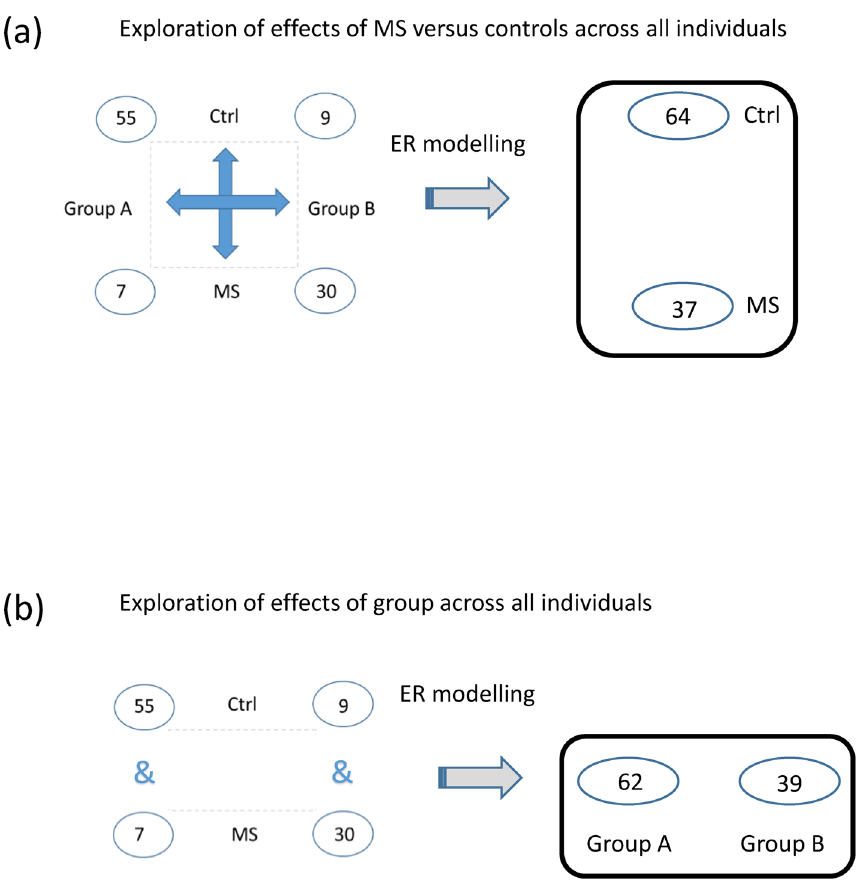
Figure 3. Cohort 1. Schematic description of ER modelling. The data are considered as two-pseudofactors, each on two levels, and the impact of one factor is omitted during exploration of the other. ER modelling allows data on all controls and all MS patients to be combined in multivariate analyses to identify ( a ) a disease-associated proteome pattern as well as ( b ) the proteome signature that drives group